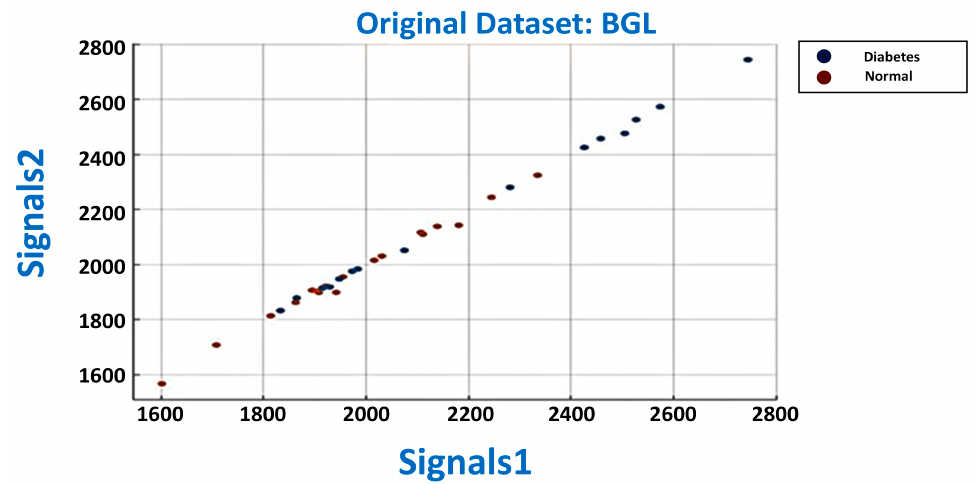
Figure 10. Data distribution of multiple measurements from PPG, which are divided into healthy objects and diabetic objects. Table 2. Comparative analysis of training results.